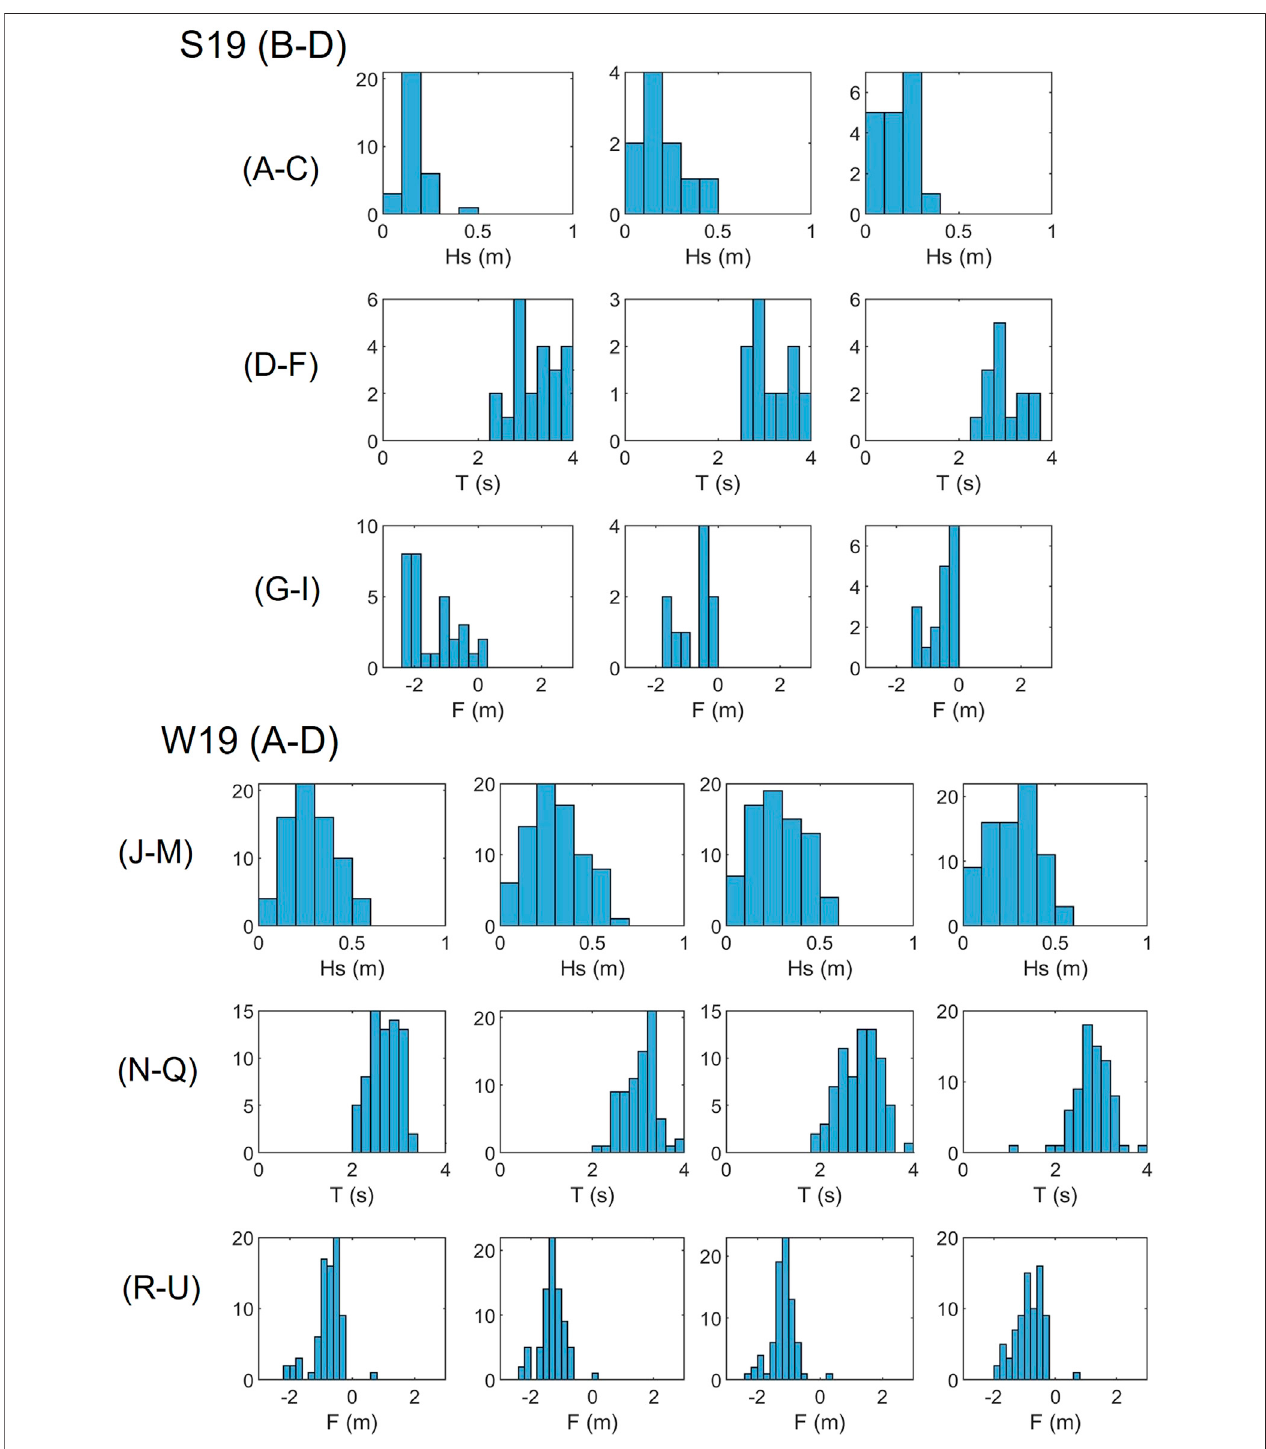
FIGURE 6 | Histograms of incident signi fi cant wave height (A – C,J – M) , period (D – F,N – P) , and freeboard (G – I,Q – T) during S19 (A – I) and W19 (J – T) for cases of K t > 1 at Site A (J,N,R) , B (A,D,G,K,O,S) , C (B,E,H,L,P,T) , D (C,F,I,M,Q,U) . Each histogram represents the entire deployment at the corresponding location.